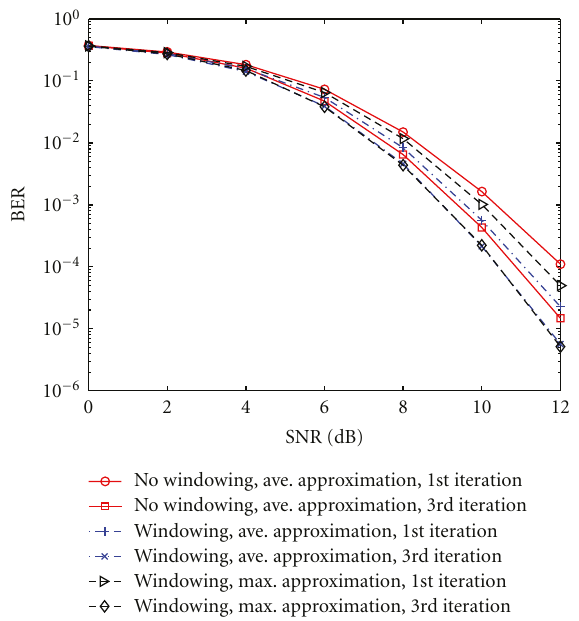
Figure 5: BER performance comparison of di ff erent equalization approaches for SC systems.